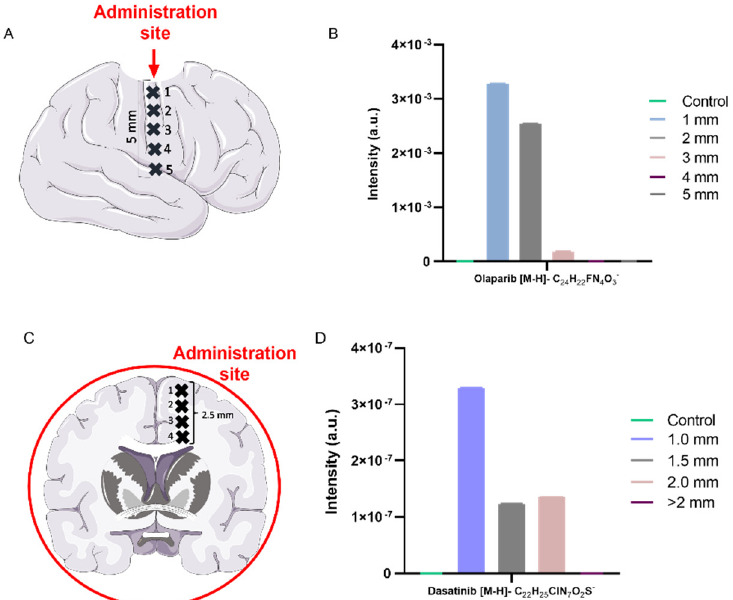
Figure 3. [M-H] − ion intensities for olaparib and dasatinib applied to whole rat or mouse brain ex vivo tissue sections ( A ) Schematic showing the cavity site in a rat brain hemisphere and the corre- sponding measurement sites at 1 mm increments distal from the administration site and ( B ) olaparib [M-H] − identified at these sites when administered using a spray device. ( C ) Schematic showing the analysis points at ≥ 0.5 mm increments in a coronal section of a mouse brain bathed in a dasatinib solution. ( D ) Dasatinib [M-H] − identified at these analysis points. Results presented are from a single measurement using 20 KeV Ar 3000 Orbitrap MS (mode 4).